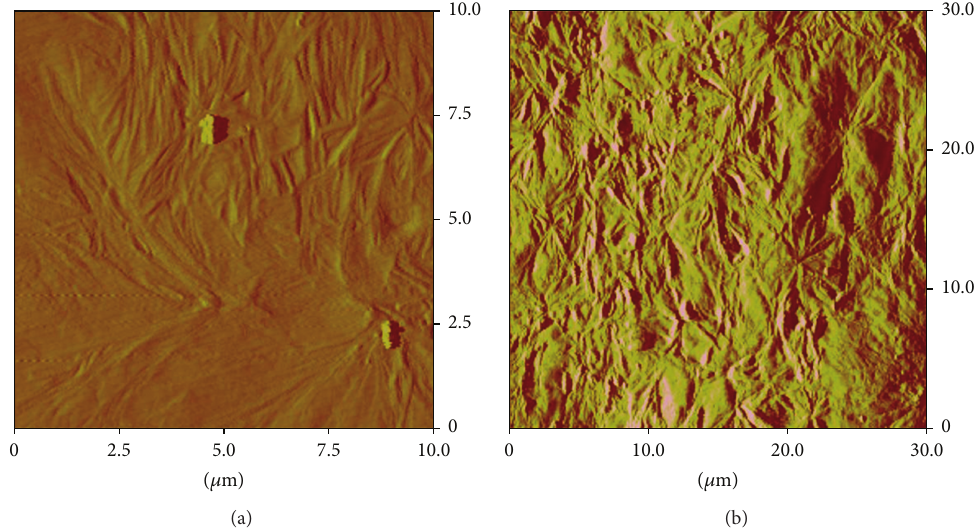
Figure 12: AFM amplitude images on different areas after complete crystallization.